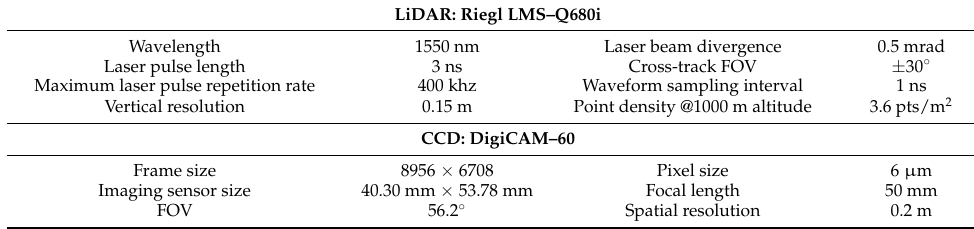
Table 1. The parameters of the sensors of the CAF–LiCHy system